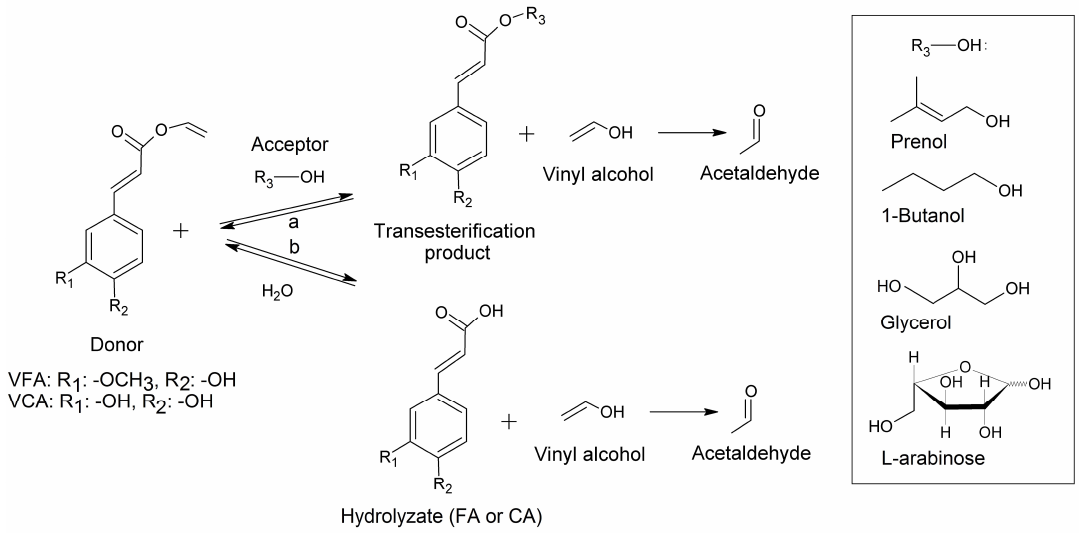
Figure 1. ( a ) Transesterification of a vinyl activated donor with acceptors of different lipophilicity (prenol, 1-butanol, glycerol, or L -arabinose); ( b ) Hydrolysis of donor observed as side-reaction during transesterification. Under normal conditions vinyl alcohol tautomerizes to